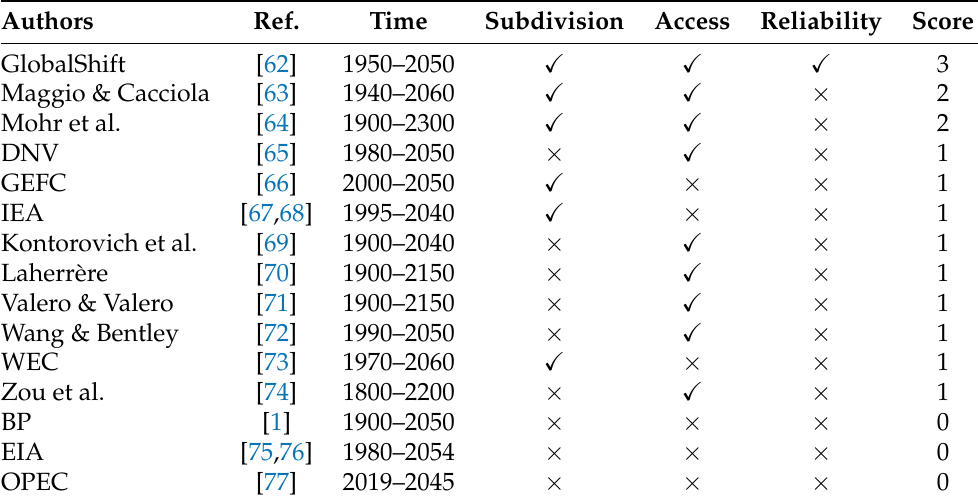
Table 2. Identified models forecasting global gas supply, sorted by descending score (total number of criteria